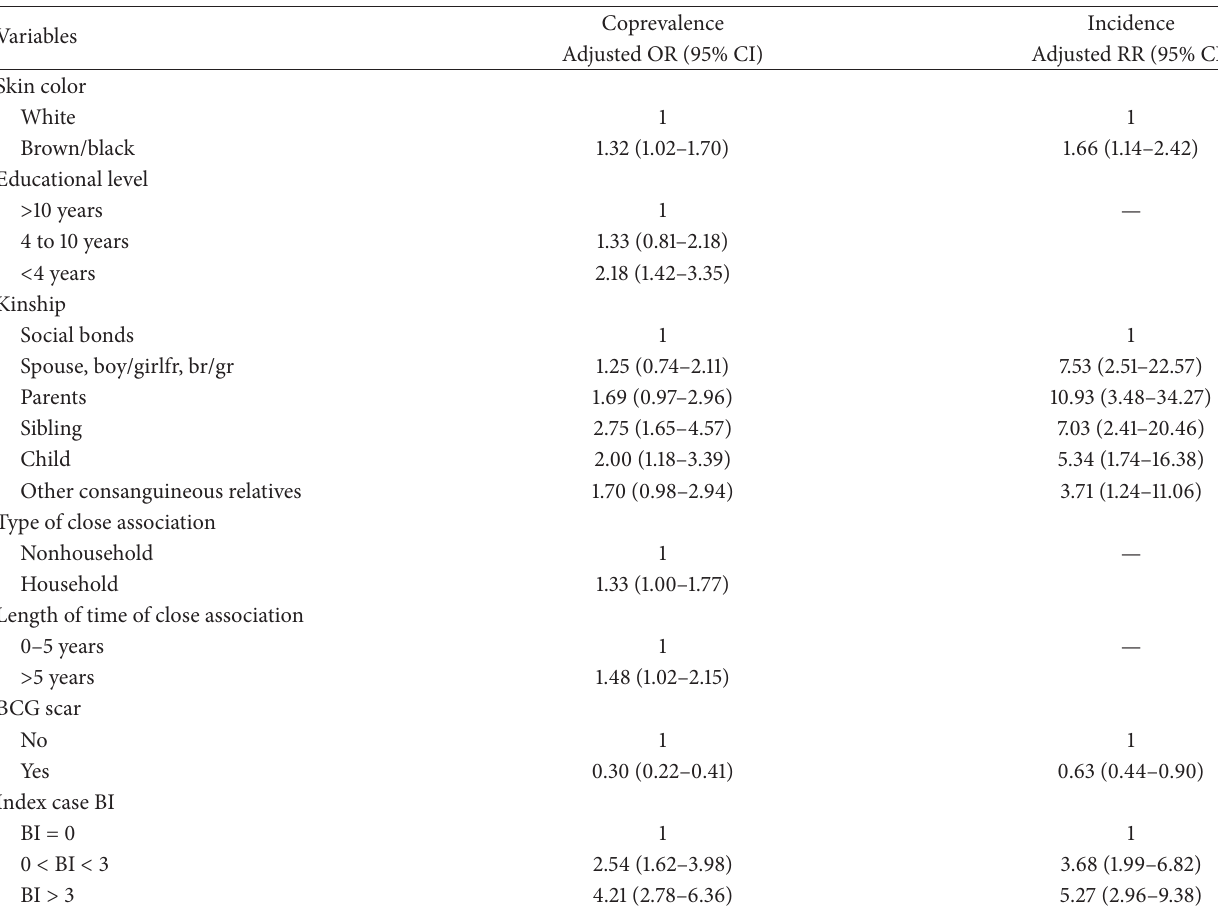
Table 2: Factors associated with prevalence and incidence in a cohort of contacts. Souza Ara´ujo Outpatient Clinic, Rio de Janeiro, RJ, 1987–